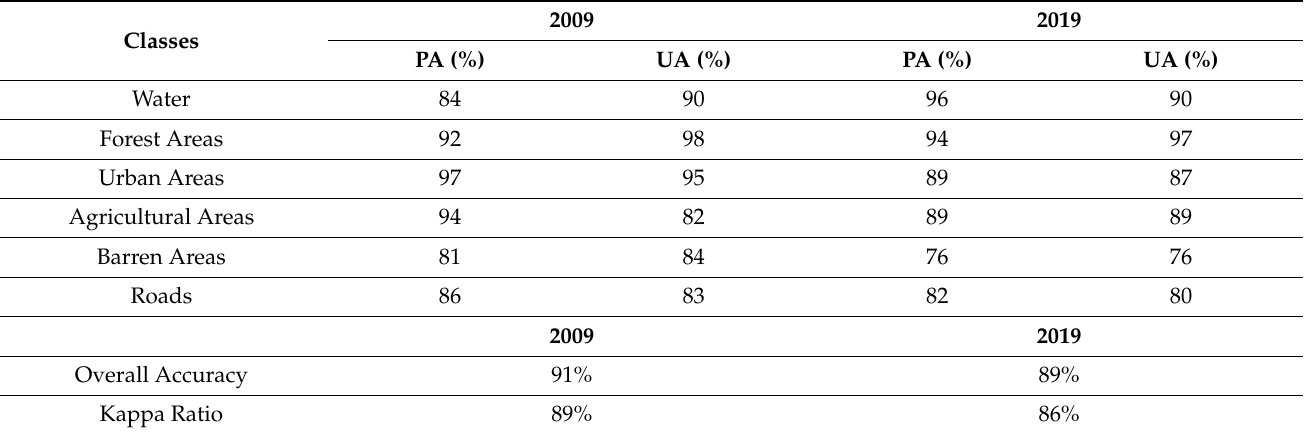
Table 4. Result of accuracy assessment.